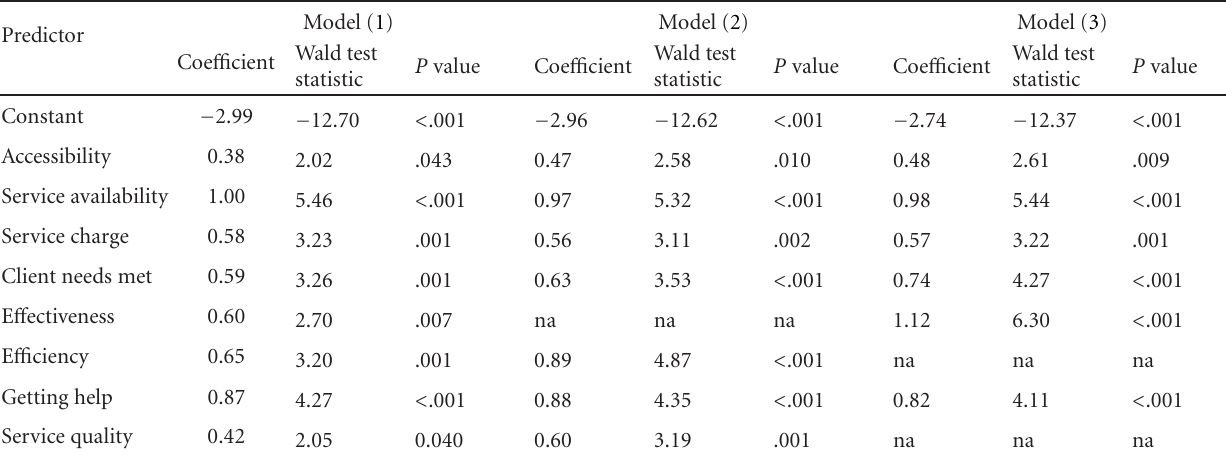
Table 2: Regression parameters for 3 models of satisfaction of clients with delivery of animal health services in peri-urban